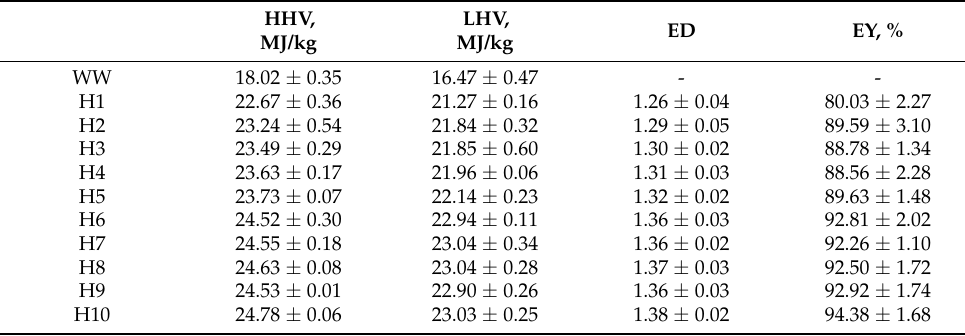
Table 3. The combustion characteristic of biomass and